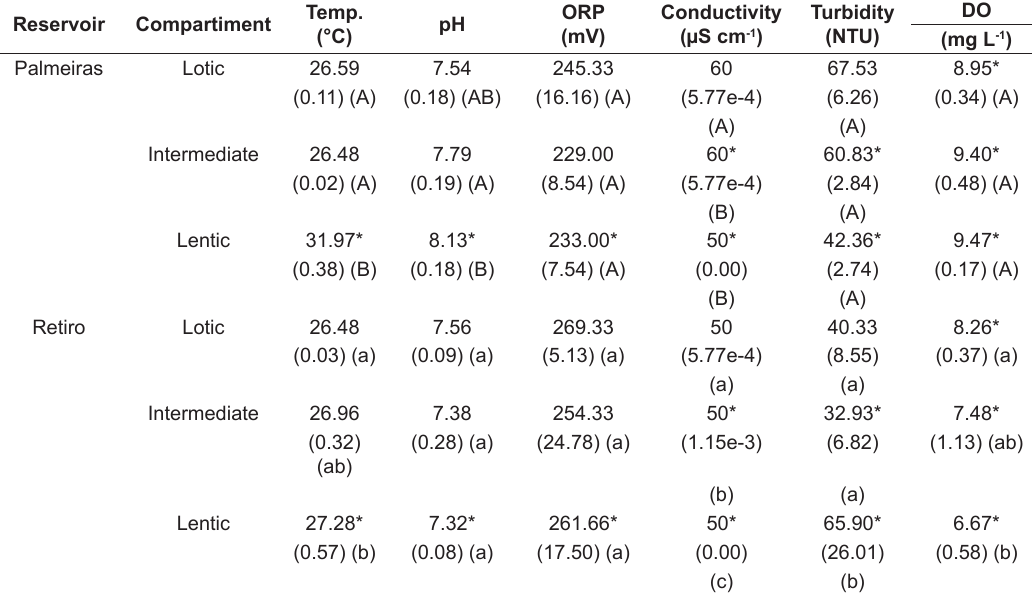
*Indicates statistical difference between reservoirs and different letters among compartments (p <0.05, ANOVA). Uppercase letters among Palmeiras compartments and lowercase letters among Retiro compartments. ORP: oxide reduction potential, NTU: nephelometric turbidity units, DO: dissolved oxygen.